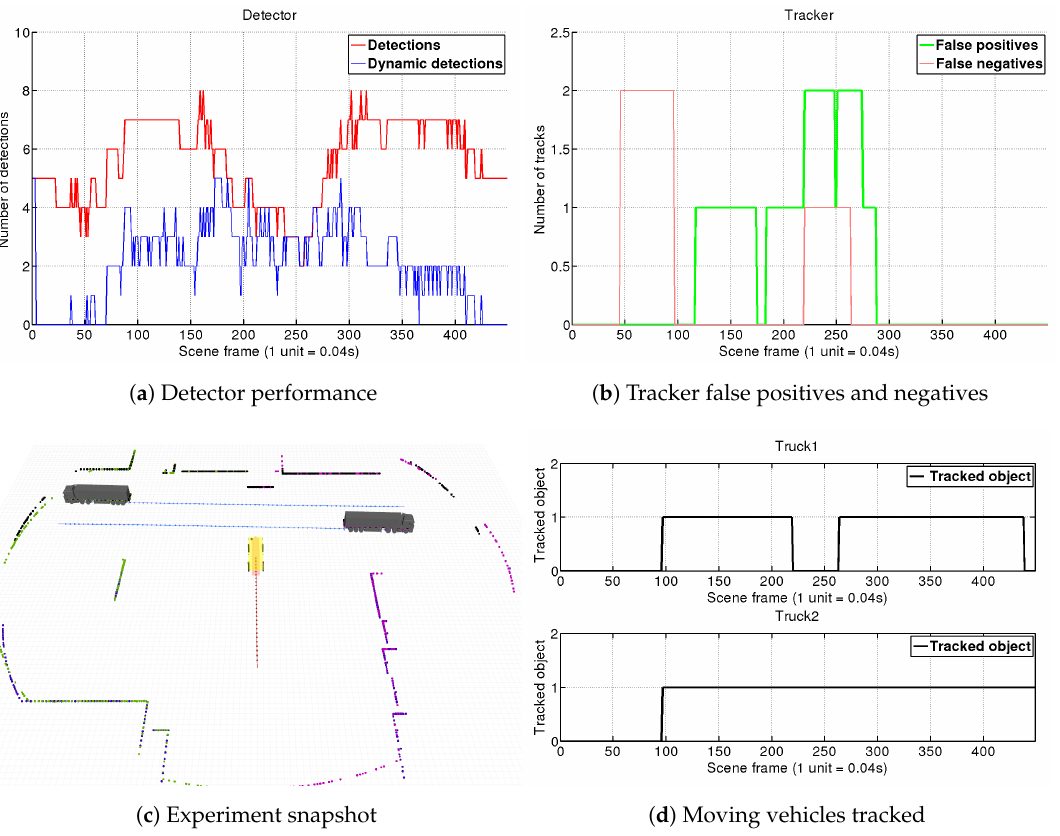
Figure 10. Scene 1. The AGV approximates an intersection where two trucks coming from both sides cross in front of it. After entering in the AGV’s field of view, our DATMO system keeps tracking both vehicles. In the mid part of the simulation, Truck 2 occludes Truck 1 , and its target is lost after a second without receiving detections being tracked again when new detections are